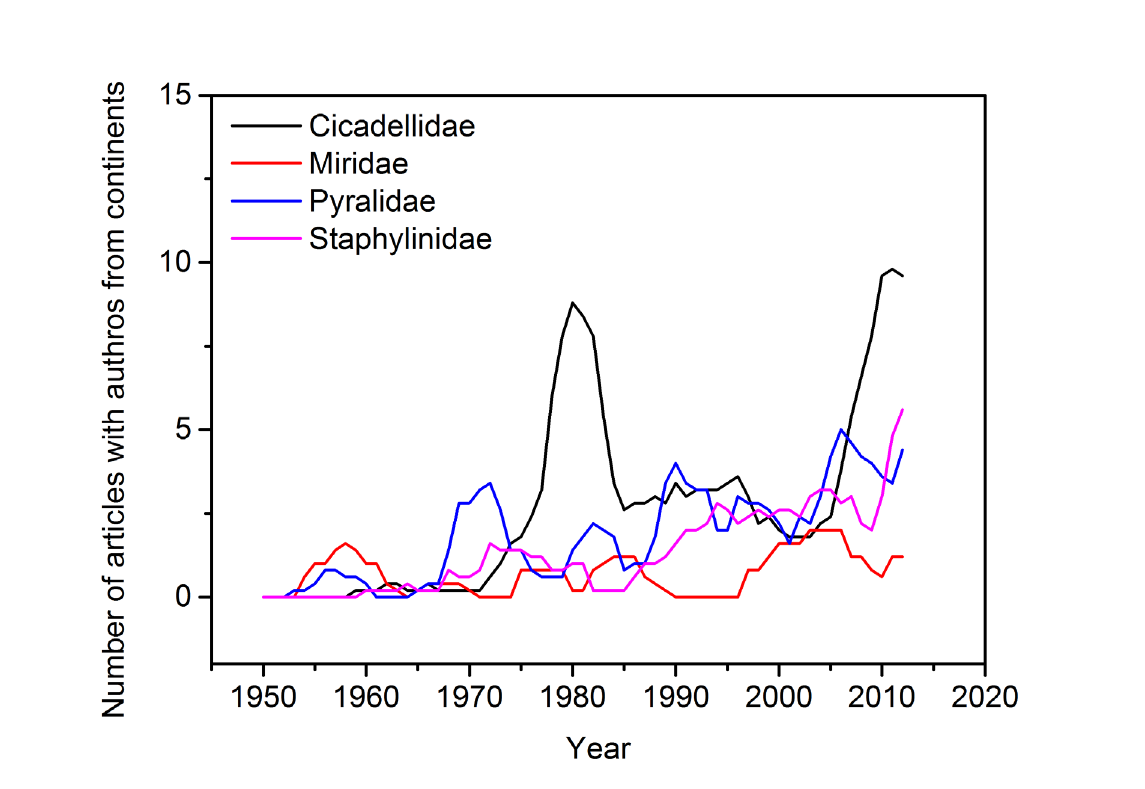
Fig 8. Number of co-authored papers with authors from different continents from 1946 to